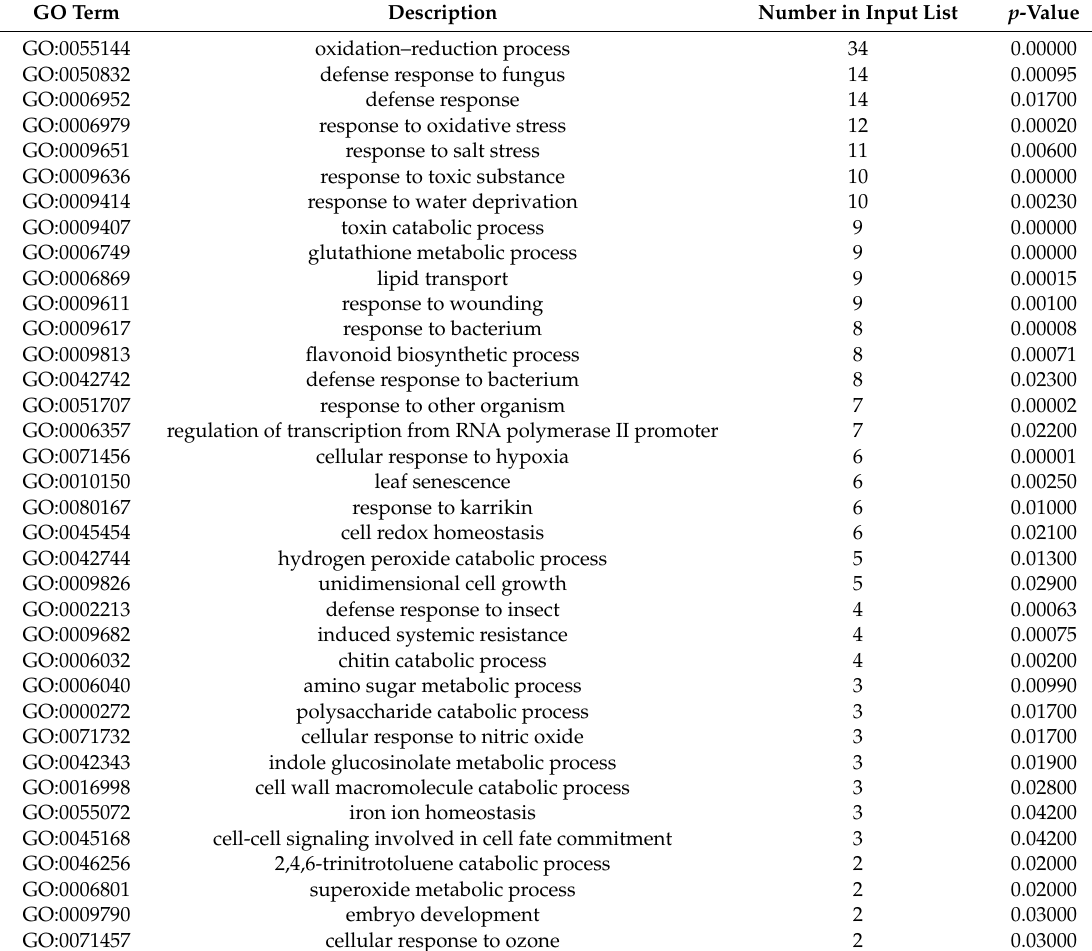
Table 2. Biological process categories of Gene Ontology (GO) annotation of upregulated genes in AtRH17 OXs.